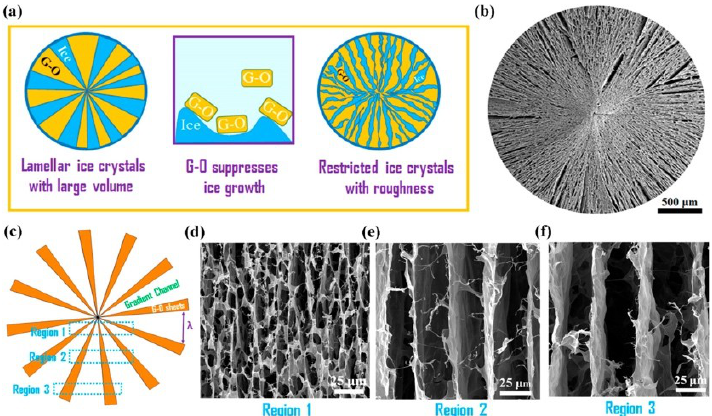
Figure 9. Schematics and images from the radially grown GO aerogels. ( a ) Illustrates the ice-templating process, ( b ) shows scanning electron microscopy (SEM) images of the radially aligned aerogel, ( c ) illustrates the decreasing width of the radial channels, which decrease from edge to center, and ( d – f ) show SEM micrographs of the sections outlined in ( c ). Adapted from [22] with permission, copyright American Chemical Society, 2018.